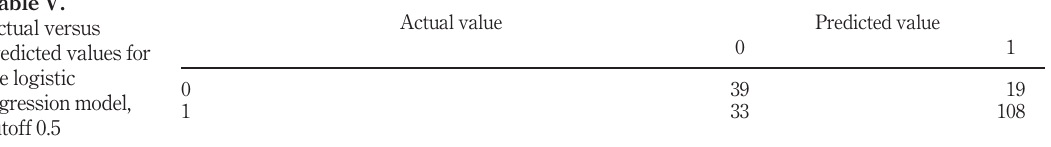
Table IV. Logistic regression model coef fi